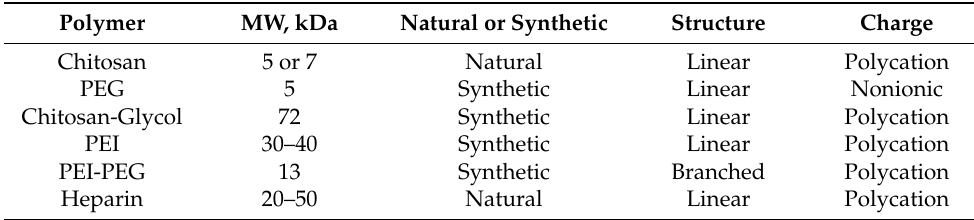
Table 1. Characteristics of polyelectrolytes used in the